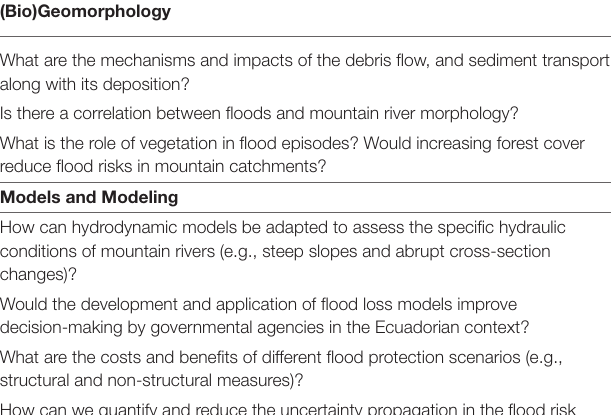
TABLE 1 | Research agenda for floods and their mitigation in Ecuadorian highlands.